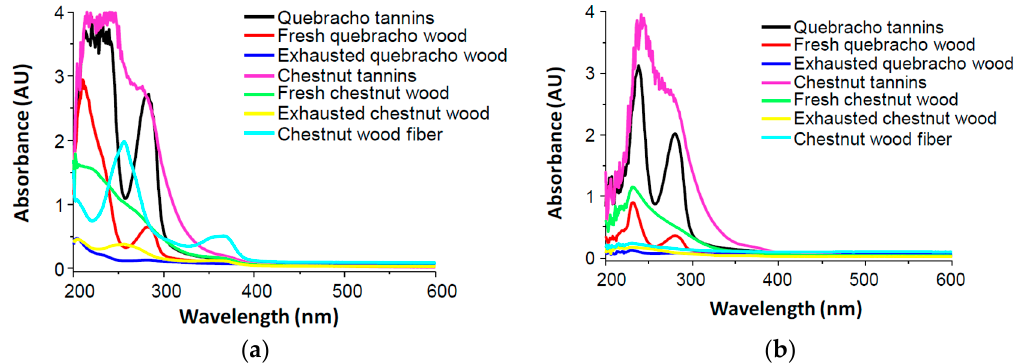
Figure 3. UV-Vis spectra of wood and tannin samples (0.15 mg/mL) in methanol ( a ) or 0.3 M acetate buffer (pH = 3.6) ( b ). Table 2. Tannin content and total phenolic content (TPC) of wood